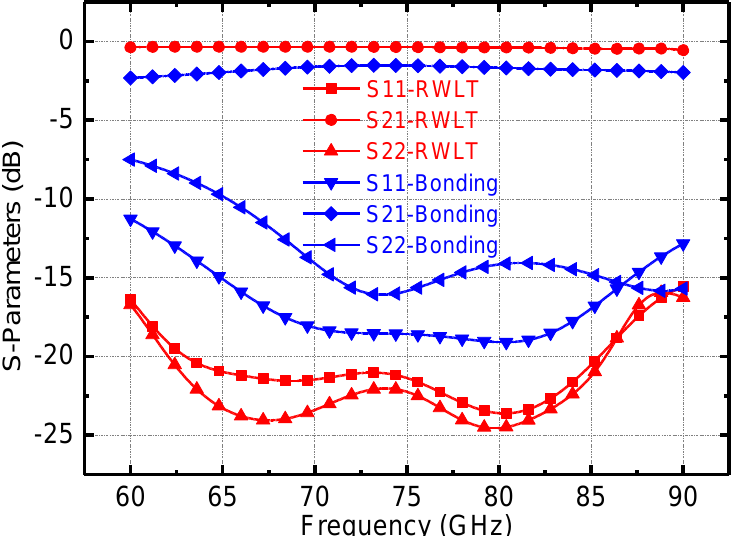
Figure 10. The simulated connection loss of the RF GSG PAD to the microstrip line and the microstrip line to the WR12 waveguide port.